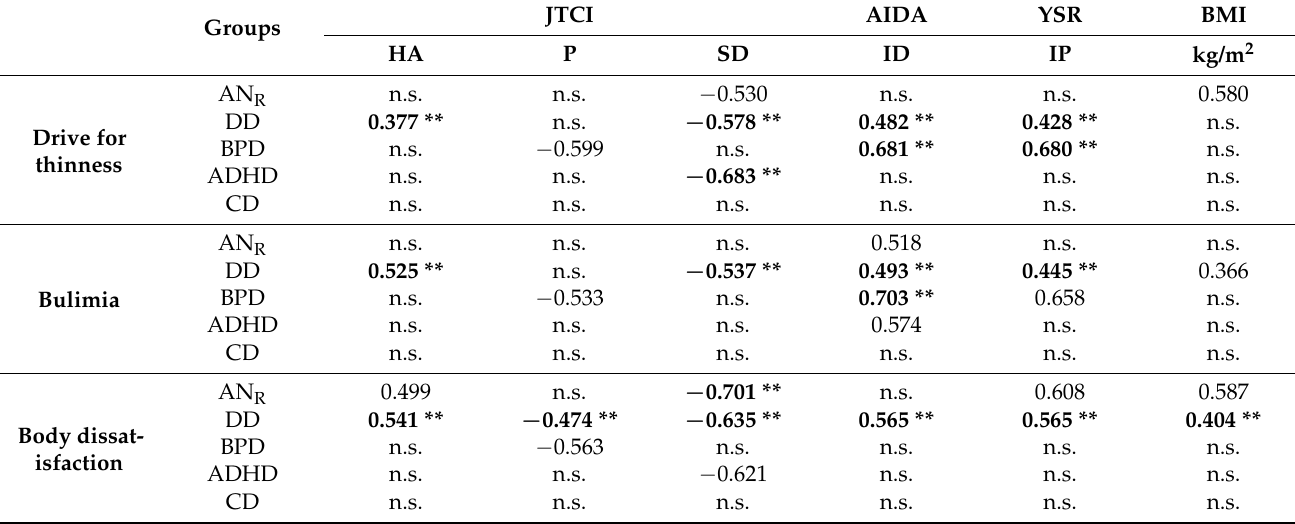
Table 5. Pearson ´ s correlation coefficients between JTCI scales, AIDA total scale, internalizing scale of Youth Self Report (YSR), and BMI and body-related scales (EDI-2) in the examined groups. Only the JTCI and YSR scales including significant values are listed ( α -level ≤ 0.01), ** p < 0.01 (bold print), p < 0.05 (light print), n.s. = not significant. Abbreviations: HA (harm avoidance), P (persistence),